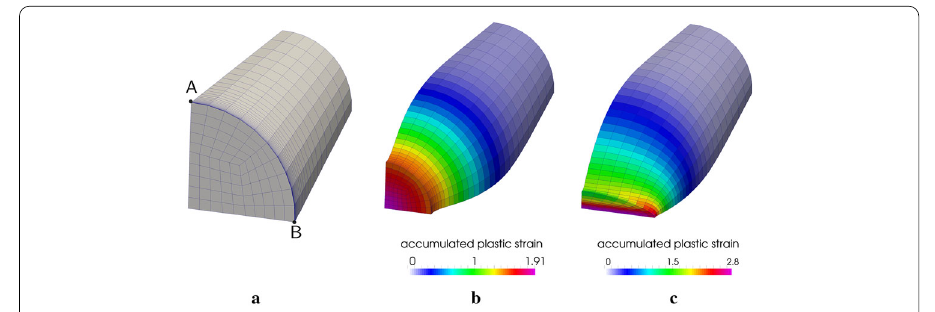
Fig. 1 Thermally triggered necking of an anisotropic circular bar—initial mesh and final deformed configuration colored by the accumulated plastic strain α i . a Initial mesh. b Final configuration, isotropic plasticity. c Final configuration, anisotropic